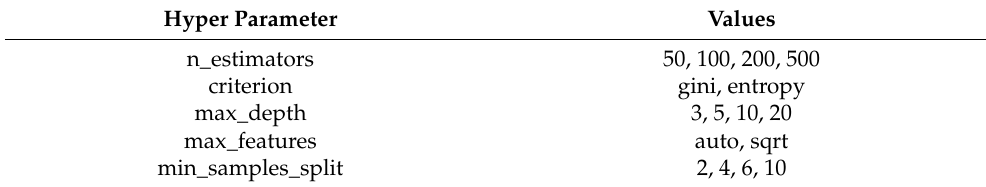
Table 3. Tested Hyper-parameters for Random Forest.